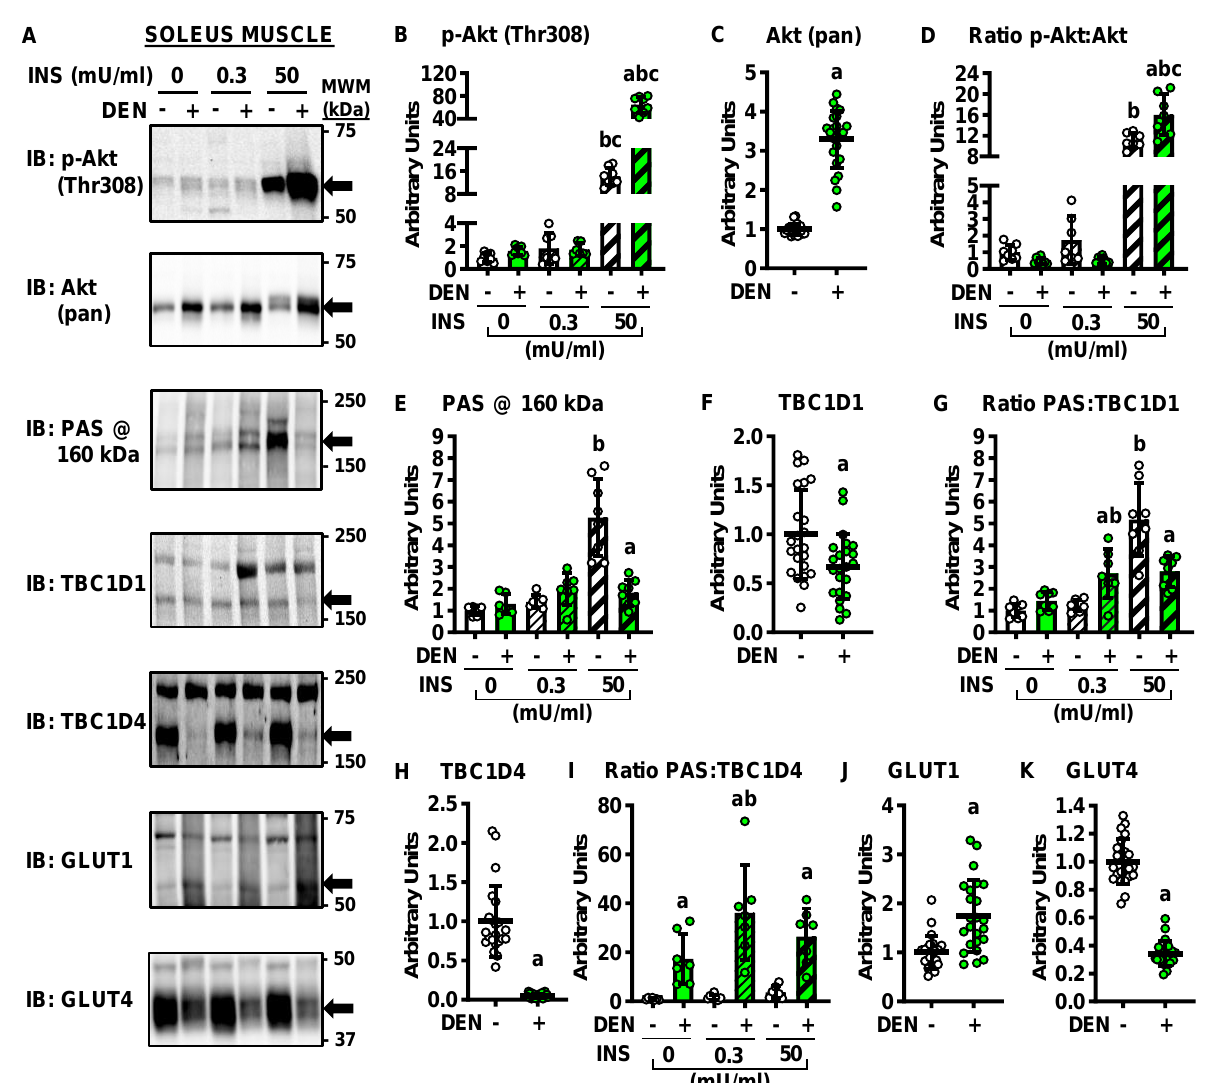
Figure 3. Effects of long-term denervation (DEN) on insulin signaling in the soleus muscle. In male wild-type mice, hindlimb muscle denervation was induced in one leg for 28 days while the contralateral leg was sham-operated. Soleus muscles were excised and incubated in 0, 0.3 or 50 mU/ml insulin (INS). ( A ) Representative immunoblots. ( B – K ) Immunoblot band quantification. Statistical significance was defined as p < 0.05, determined using paired t -tests (for pooled total proteins; panels ( C , F , H , J and K ); n = 22–23 muscles/group), or two-way ANOVAs and Tukey’s post-hoc analysis (panels ( B , D , E , G and I ); n = 6–8 muscles/group), and denoted by ‘a’ vs. -, ‘b’ vs. 0 mU/ml INS, and ‘c’ vs. 0.3 mU/ml INS. GLUT = glucose transporter; PAS = phospho-Akt substrate.